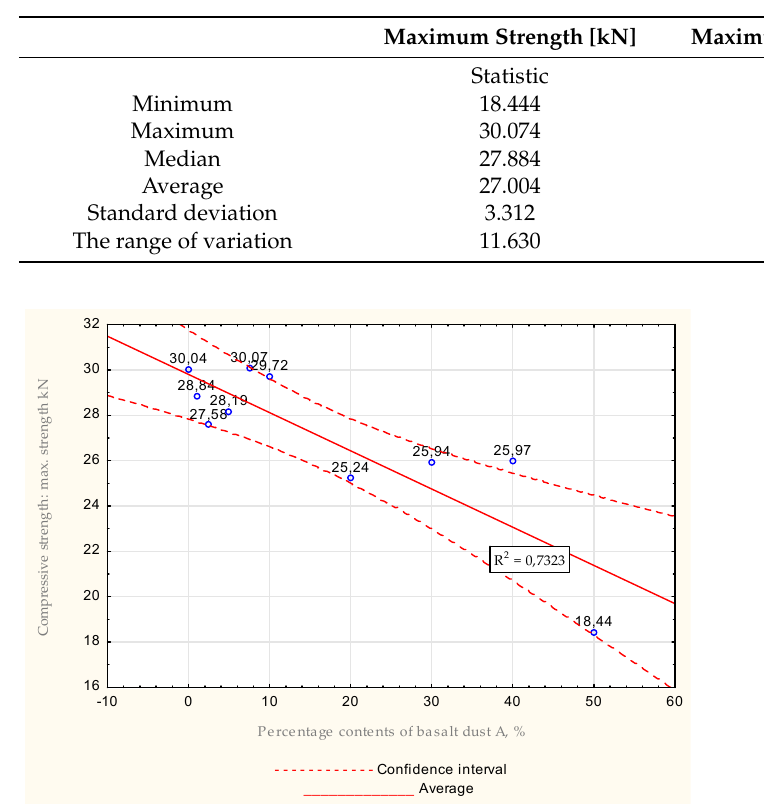
Figure 25. Average values obtained during compressive strength tests for water − mix ratio = 0.7, maximal strength.